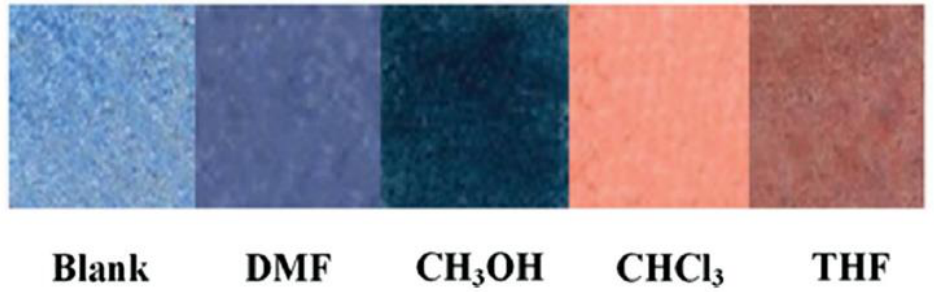
Figure 12. Photographs of the PDA / graphene films after exposure to dimethylformamide (DMF), methanol (CH 3 OH), chloroform (CHCl 3 ), and tetrahydrofuran (THF) vapors for 2 min [89].